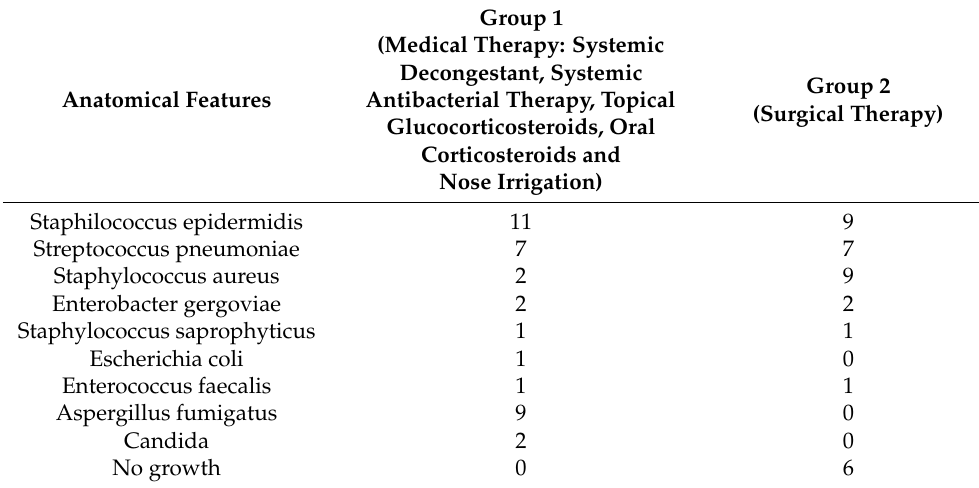
Table 4. The microbial composition of the nose and of the sphenoid sinus were performed in patients who underwent endoscopic